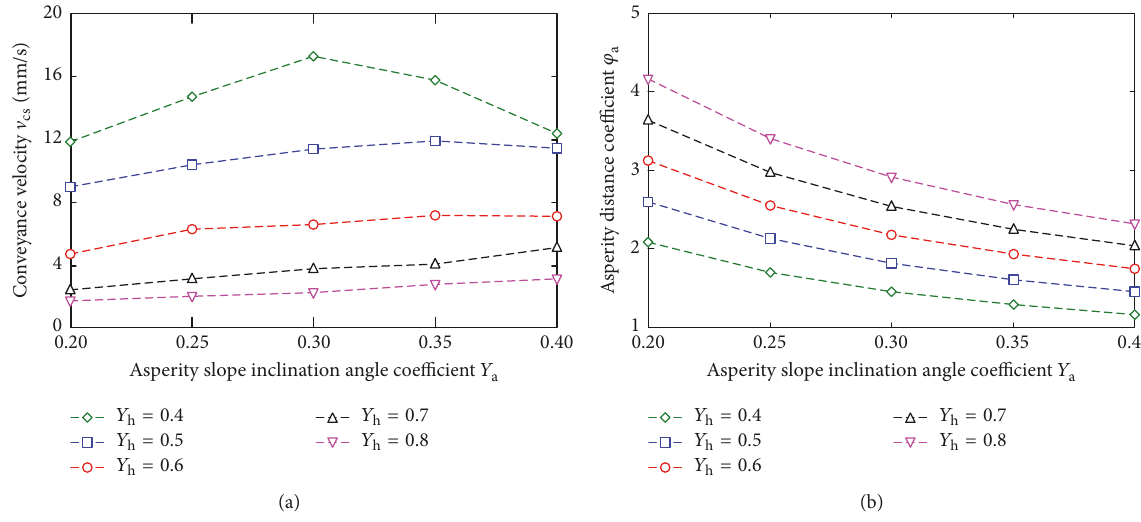
Figure 18: (a) The influence of 𝑌 h and 𝑌 a on V cs and (b) the effects of 𝑌 h and 𝑌 a on 𝜑 a